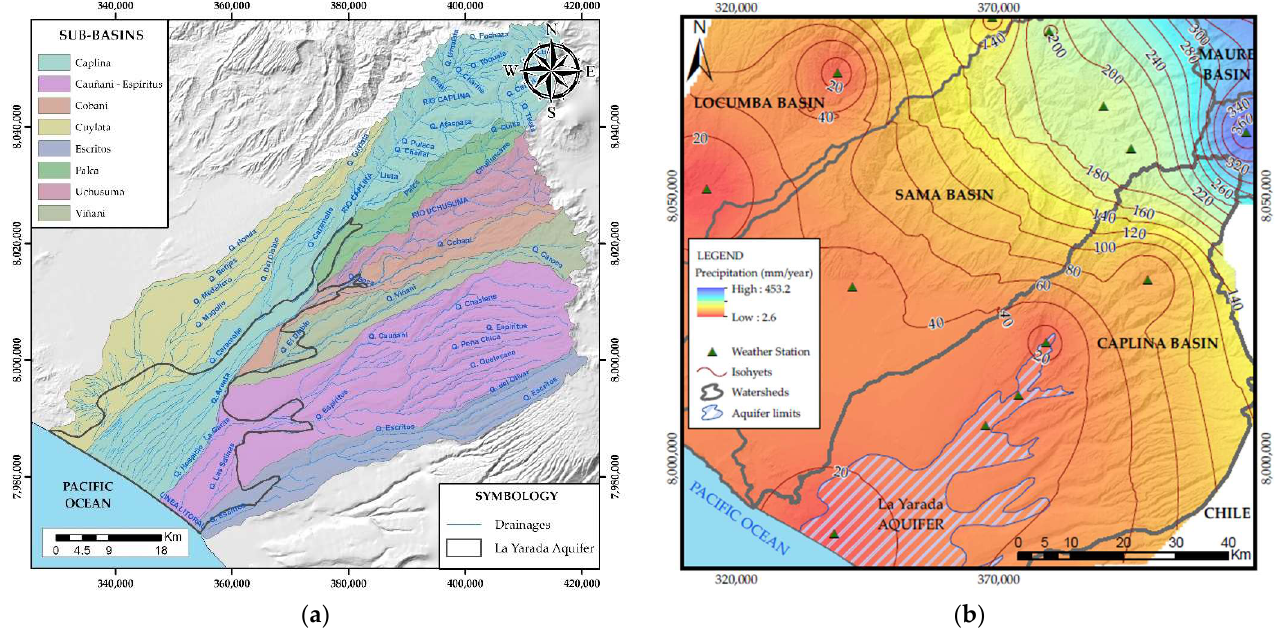
Figure 4. ( a ) Sub-basins of the Caplina basin. ( b ) Precipitation isohyets in the Caplina basin.